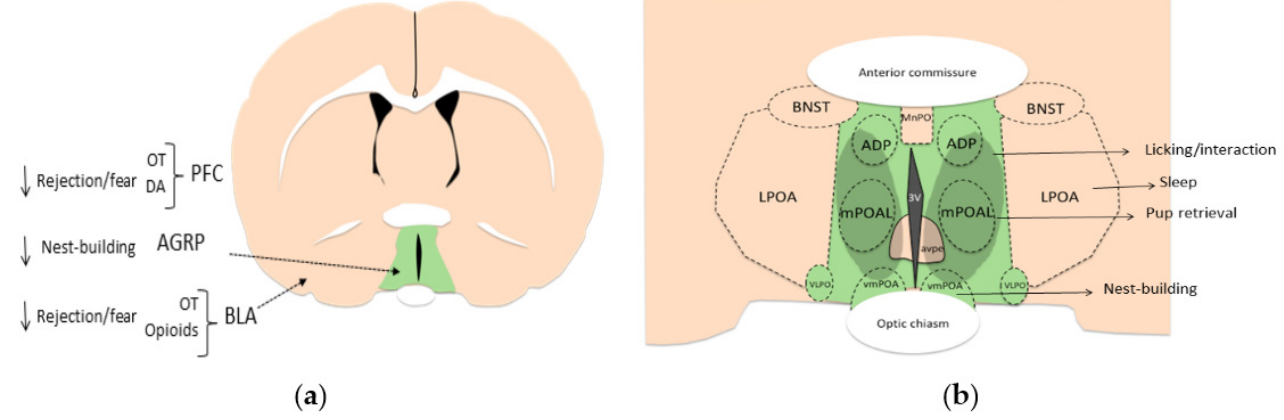
Figure 2. ( a ) Coronal drawing of a rat brain (modified from [132]). The green region represents the medial preoptic area (mPOA) as the main generator of maternal motivation via oxytocin (OT) and dopamine (DA) activity. Agouti-related peptide (AGRP) facilitates rejection in mPOA, but OT, DA, and opioids reduce rejection via other regions such as prefrontal cortex (PFC, not shown) and basolateral amygdala (BLA). ( b ) Amplification of the mPOA and subregions in the rat brain. Darker green spot represents putative galanin/ER+ neurons that mediate the expression of licking and pup retrieval in the lateral (mPOAL) and dorsal (ADP) parts of mPOA, where OT neurons are also found (modified from [103]). Nest-building depends on the activity of the ventral portion of the mPOA (vmPOA). Also shown are the bed nucleus of stria terminalis (BNST), median preoptic nucleus (MnPO), ventrolateral nucleus (vlPO), anteroventral periventricular nucleus (avpv), and lateral preoptic area (LPOA) that mediates sleep. Different mPOA subregions mediate diverse maternal behaviors interacting with mesolimbic regions. Table 3. Brain areas and neurochemicals associated with maternal behaviors. Medial amygdala (MeA), bed nucleus of stria terminalis (BNST), cortical amygdala (CoA), medial preoptic area (mPOA), ventral tegmental area (VTA), basolateral amygdala (BLA), nucleus accumbens (NAc), prefrontal cortex (PFC), oxytocin (OT), estrogen (E2), prolactin (PRL), dopamine (DA), vesicular GABA